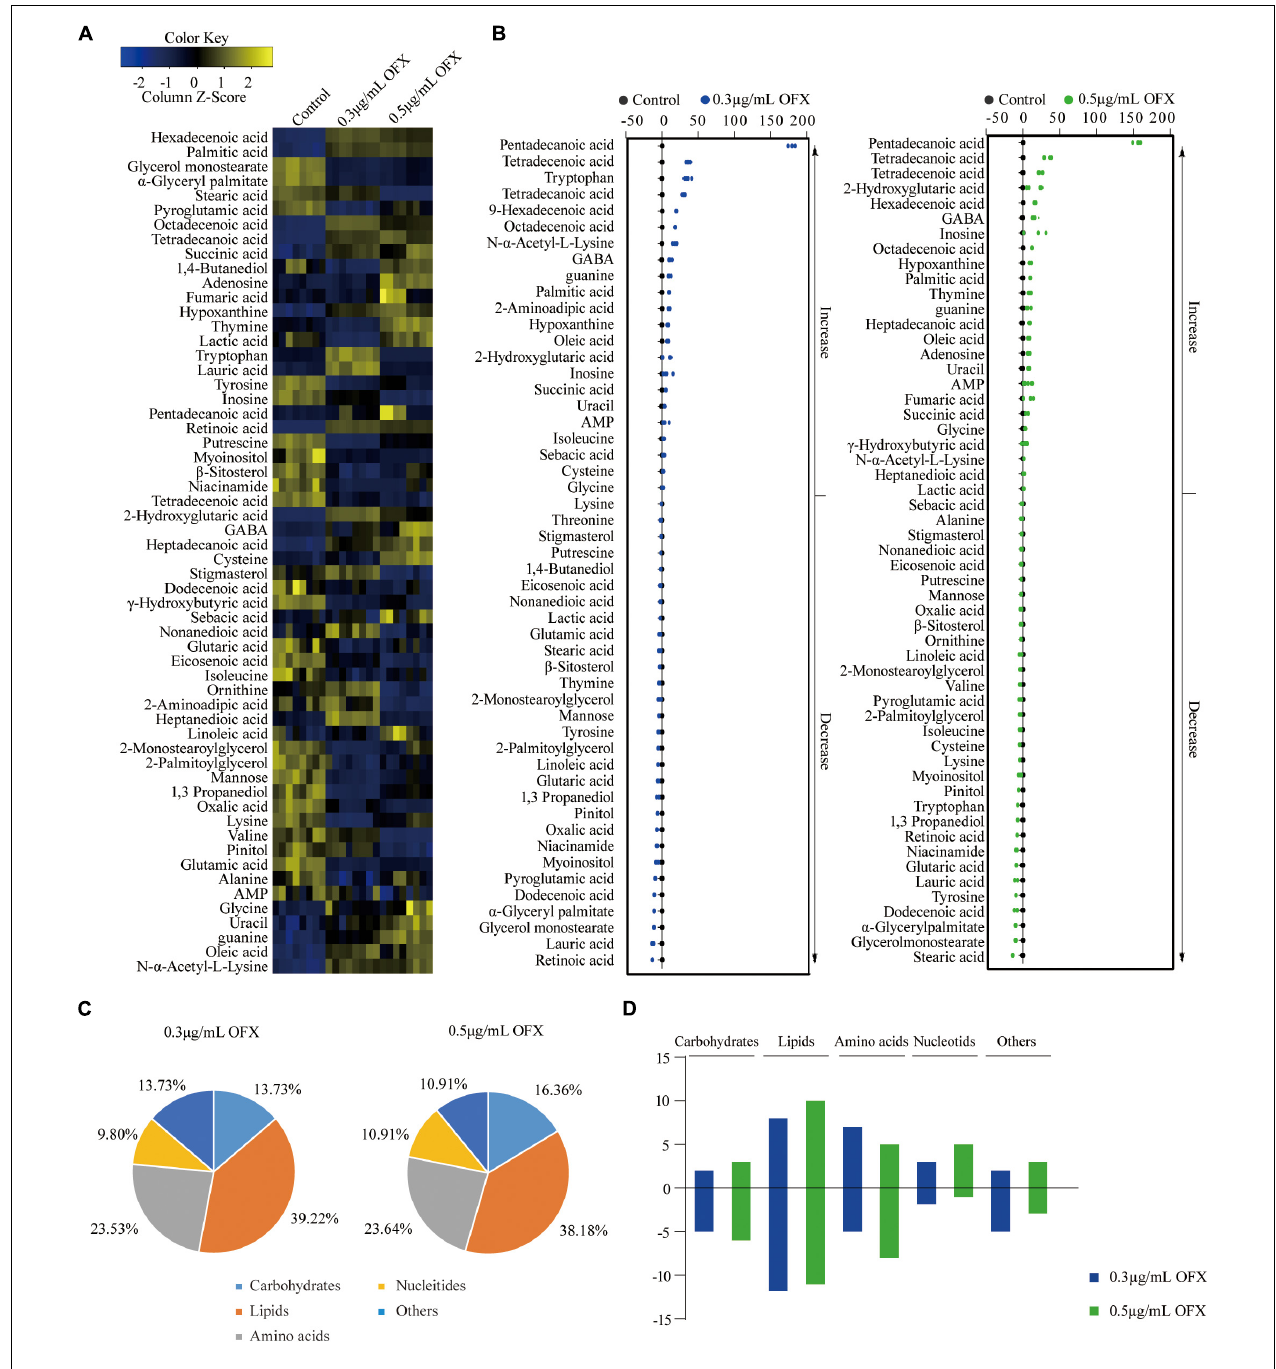
FIGURE 3 | Differential abundance of metabolites in response to OFX. (A) Heat map showing relative abundance of metabolites (Wilcoxon P < 0.05) in control, 0.3 µ g/ml OFX, and 0.5 µ g/ml OFX groups. Scale is shown at bottom, where blue to yellow represents low-to-high abundance. (B) Z-score plot of differential metabolites based on control. Z-score varied between –6.63 and 89.50 for 0.3 µ g/ml OFX to control, between –6.94 and 80.00 for 0.5 µ g/ml OFX to control. Each point represents one metabolite in one technical repeat and is colored by sample types. (C) Percentage of differential abundance of metabolites in different functional categories. (D) The number of metabolites increased and decreased in different